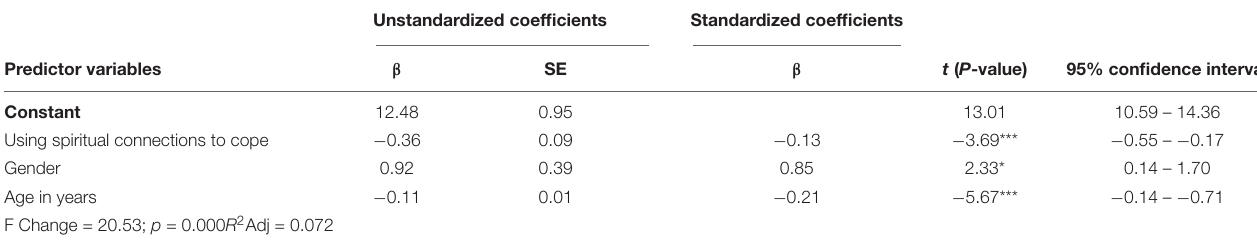
TABLE 4 | Multiple linear regression model: stress as dependent variable ( n =